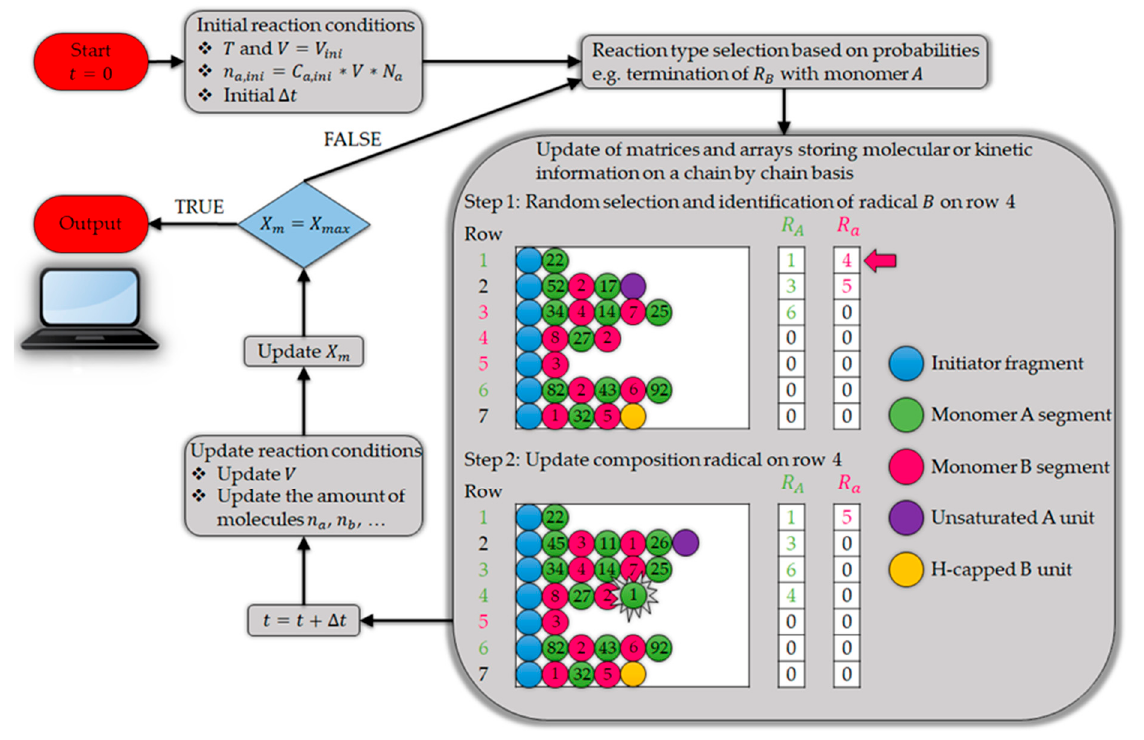
Figure 10. The flowchart of the mechanistic modeling approach (kMC) for the polymerization process developed by De Smit et al. [136], which tracks individual species and provides detailed information about the molecular structures within a chain. Reproduced from [136] with permission from the Royal Society of Chemistry. Royal Society of